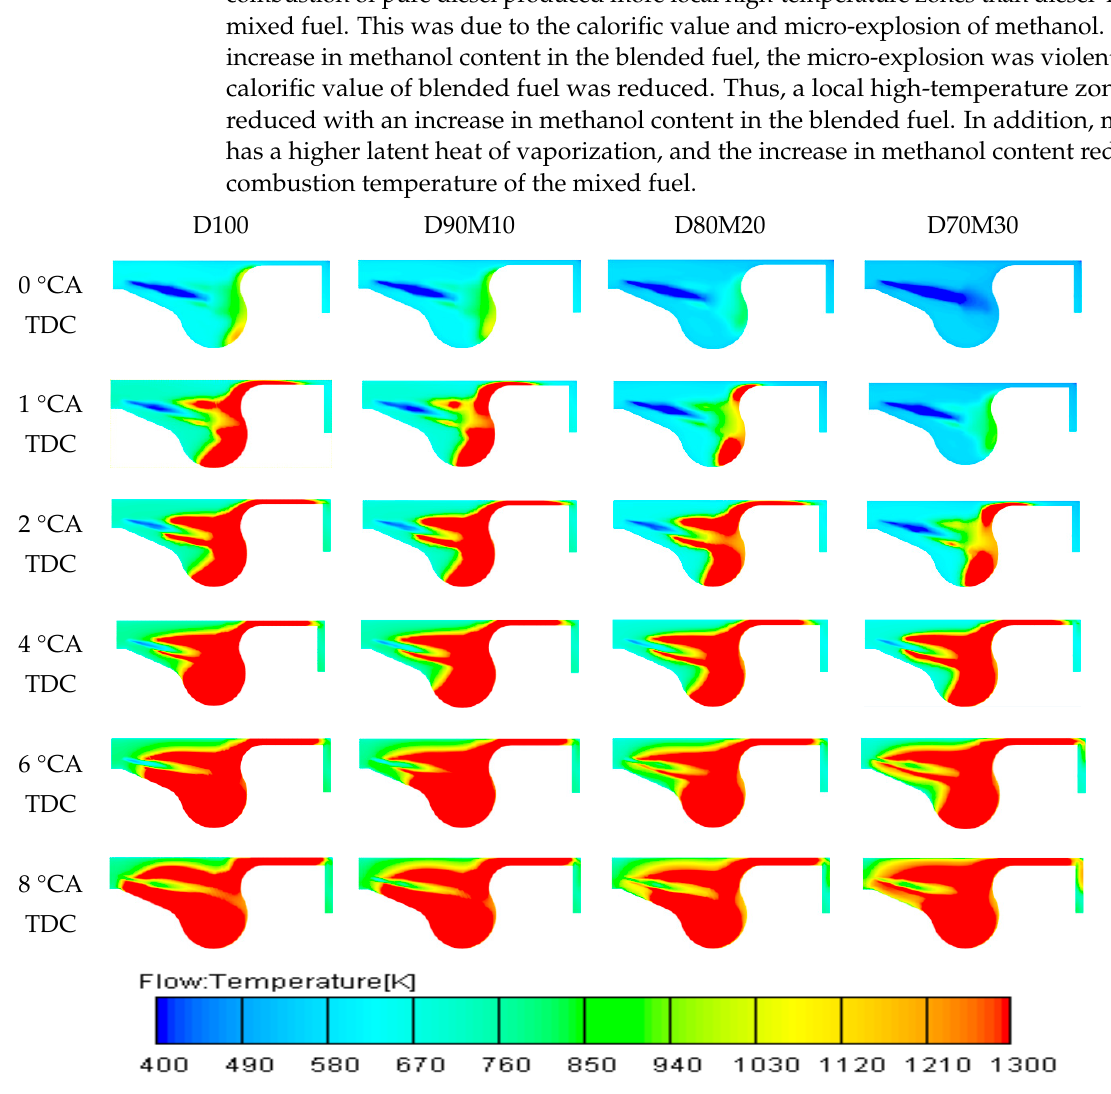
Figure 9. The distribution field of the temperature in cylinder.